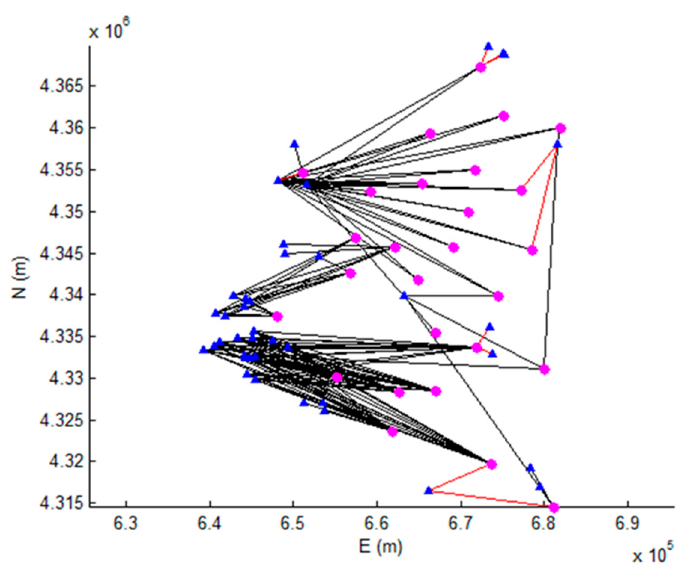
Figure 2. Graphic representation of the links between source nodes and destination nodes. Blue triangles represent source nodes; magenta circles represent destination nodes; black lines represent connections between source nodes and destination nodes; and red lines represent connections between source nodes and destination nodes with pump stations.